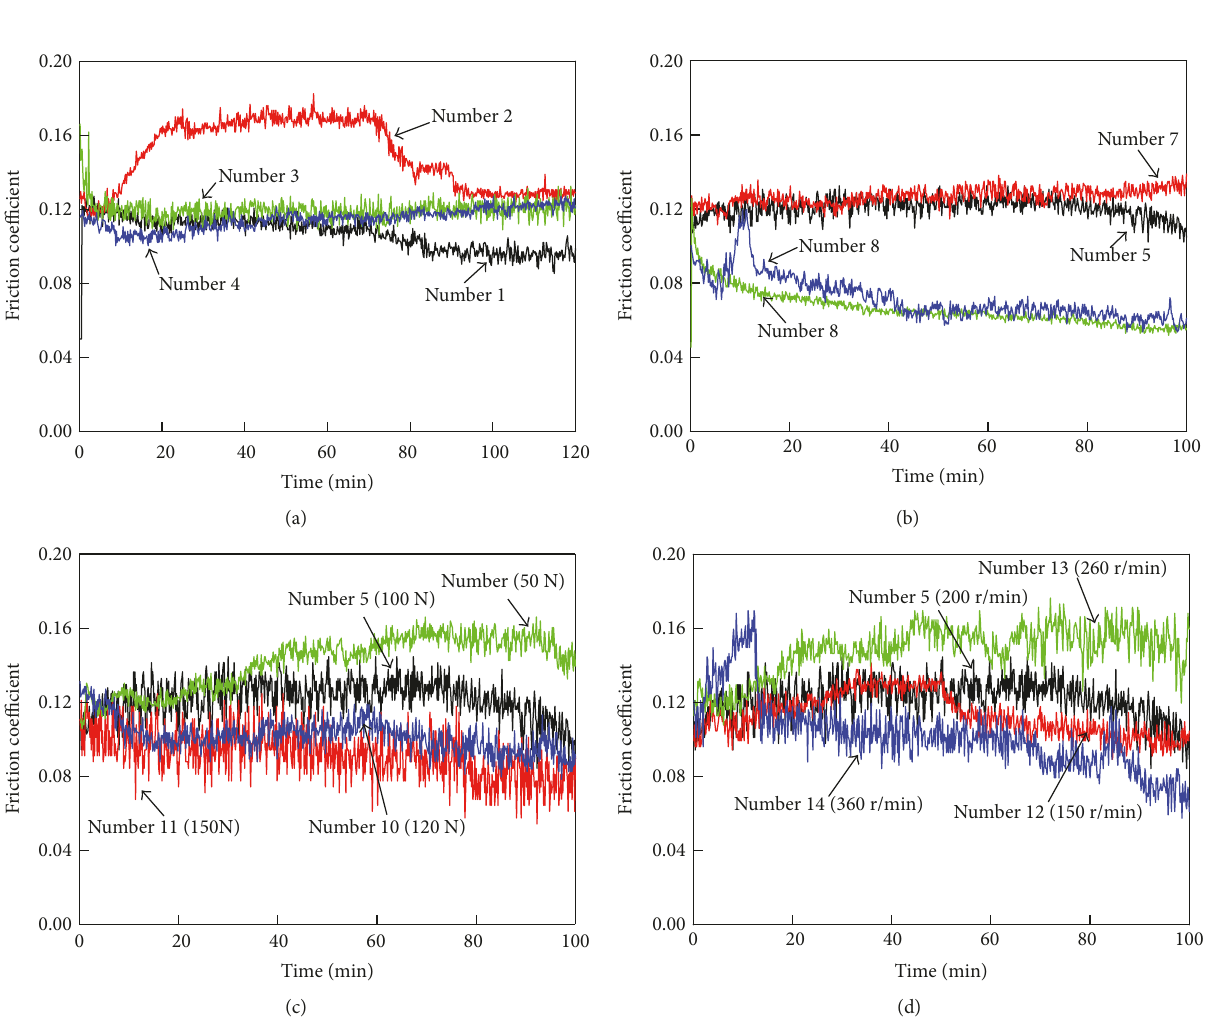
Figure 2: Variations of friction coe ffi cient with time under di ff erent materials (a), surface treatments (b), loads (c), and rotation speeds